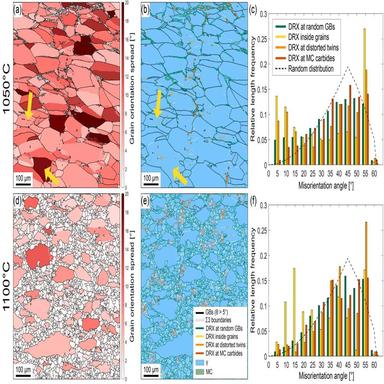
Alloy 2 deformed at (a)-(c) 1050 ◦C and (d)-(f) 1100 ◦C with a 0.1 s − 1 strain rate to 0.6 strain; (a) & (d) show the GOS before grains were merged along Σ3 twins; (b) & (e) show the phase maps with the categorised DRX grains indicated in different colours; (c) & (f) show the misorientation angle distribution between the different categories of DRX grains and deformed grains (the order in the legend corresponds with the order in the histogram).